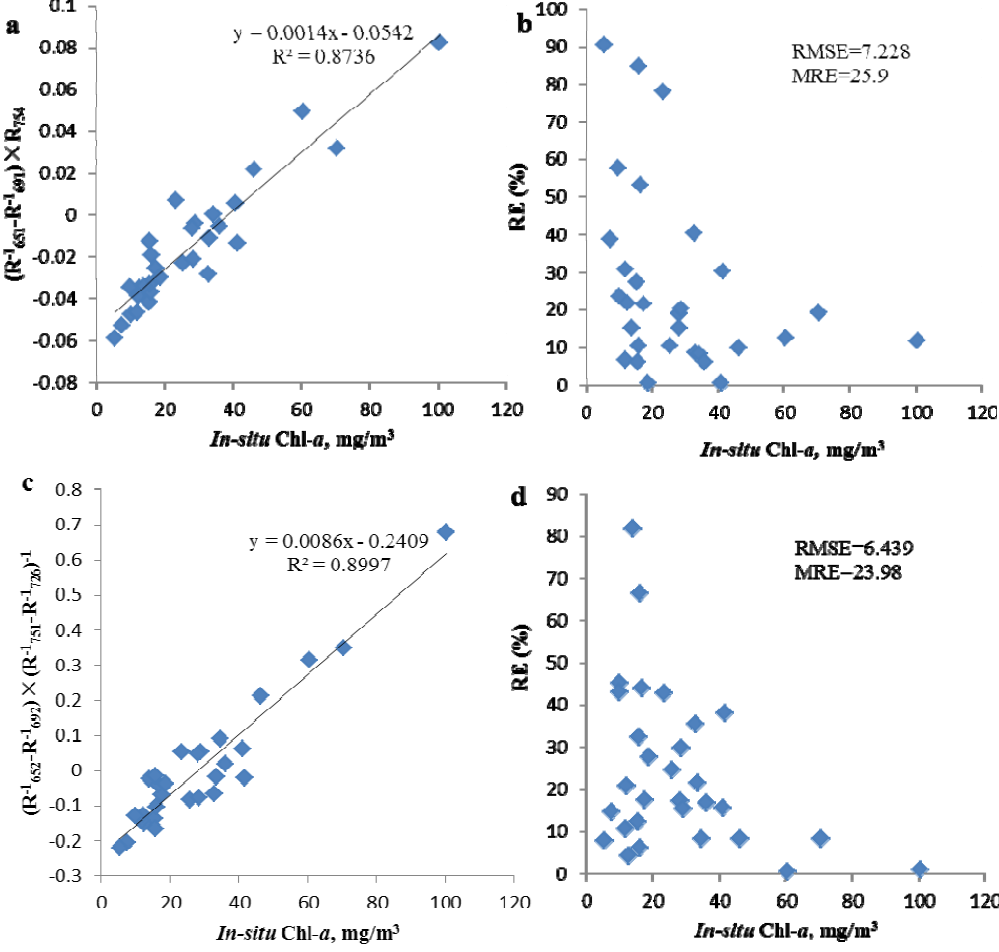
Figure 5. Linear regression of field spectral multi-band indices versus in-situ Chl- a concentrations. ( a ) Linear regression for three-band index; ( b ) relative error (RE) of the linear regression for three-band index; ( c ) Linear regression for four-band index; ( d ) RE of the linear regression for four-band